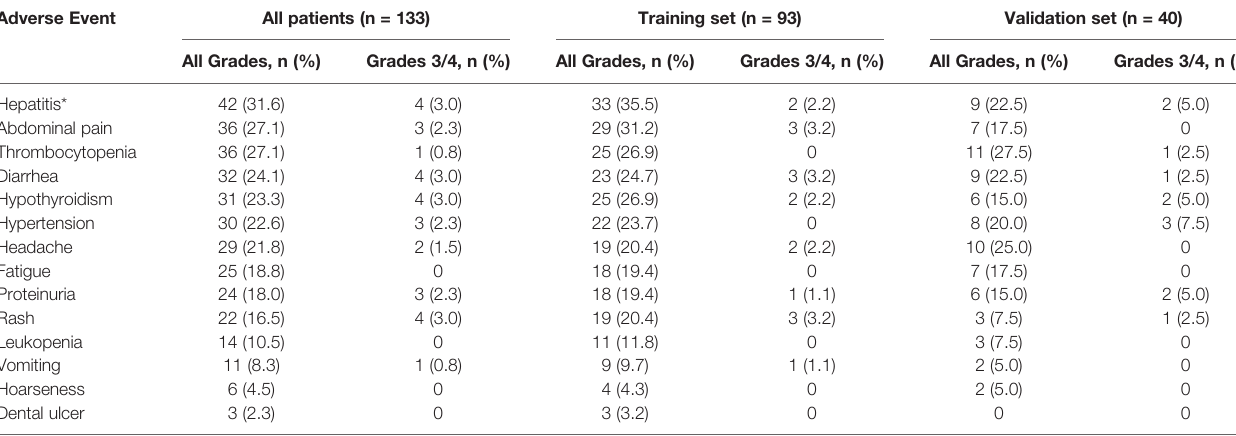
TABLE 3 | Treatment-related adverse events in the training and validation